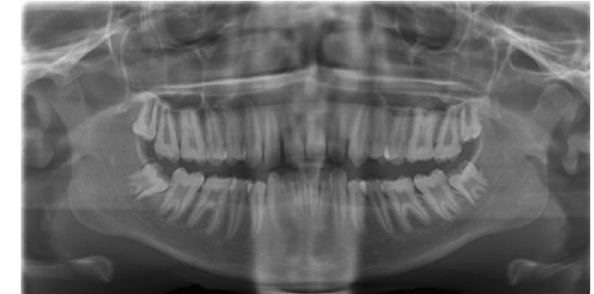
Fig. 3 Panoramic radiograph showing taurodontism in a patient with OI XI. Panoramic radiograph of a Black African male with OI XI, aged 18 years with features of varying degrees of taurodontism in all his